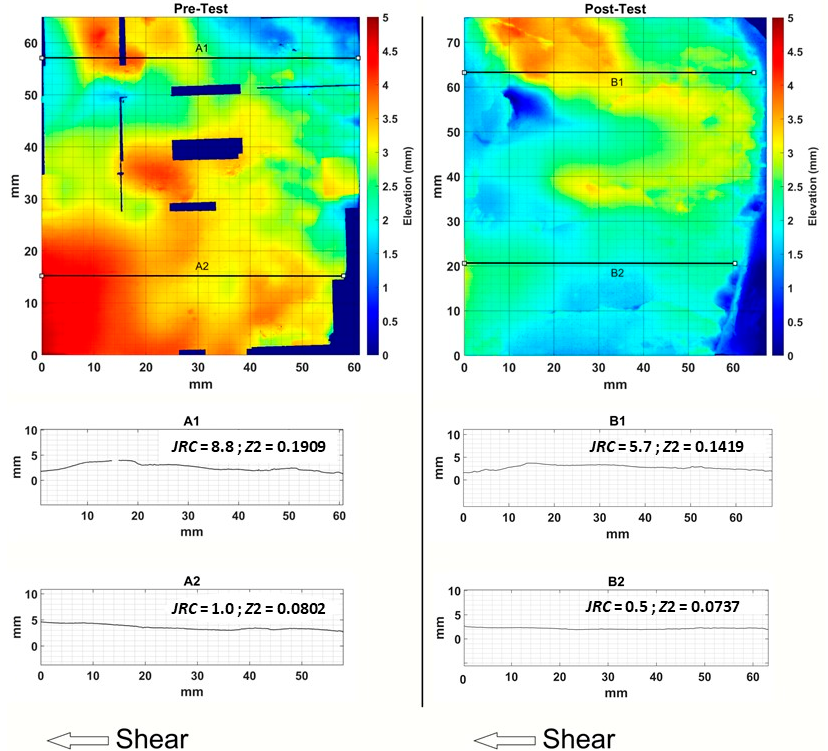
Figure 6. Topography of the fracture surface before and after the direct shear test (Draupne DST15). The arrow on the figure shows the direction of shearing. The roughness values of JRC and Z 2 are portrayed with their respective profile.